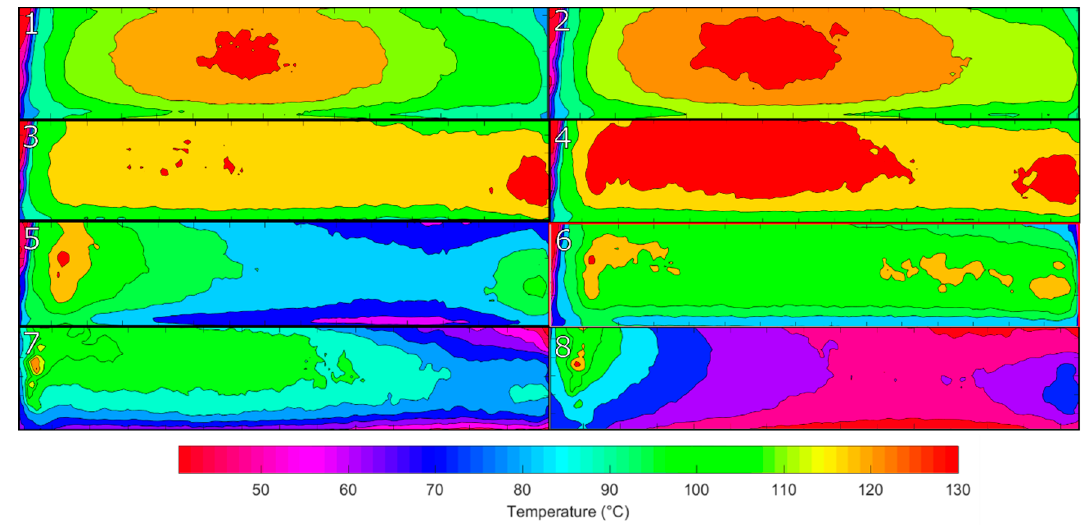
Figure 15. Contour plots of the surface temperature profile measurements shown after each cycle of ablation using the 50% method to ablate element.